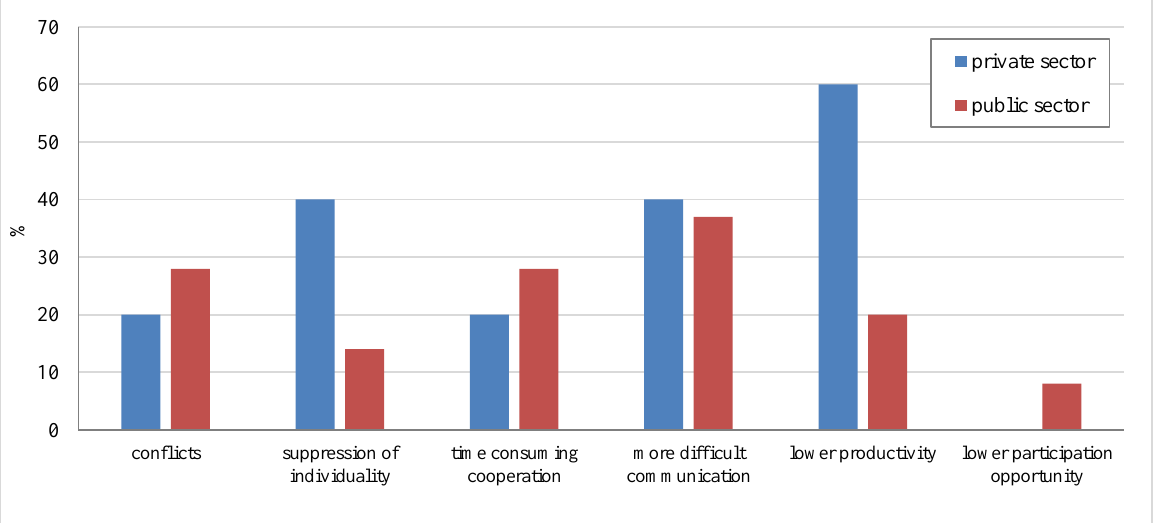
Figure 4. What negatives do you perceive in your